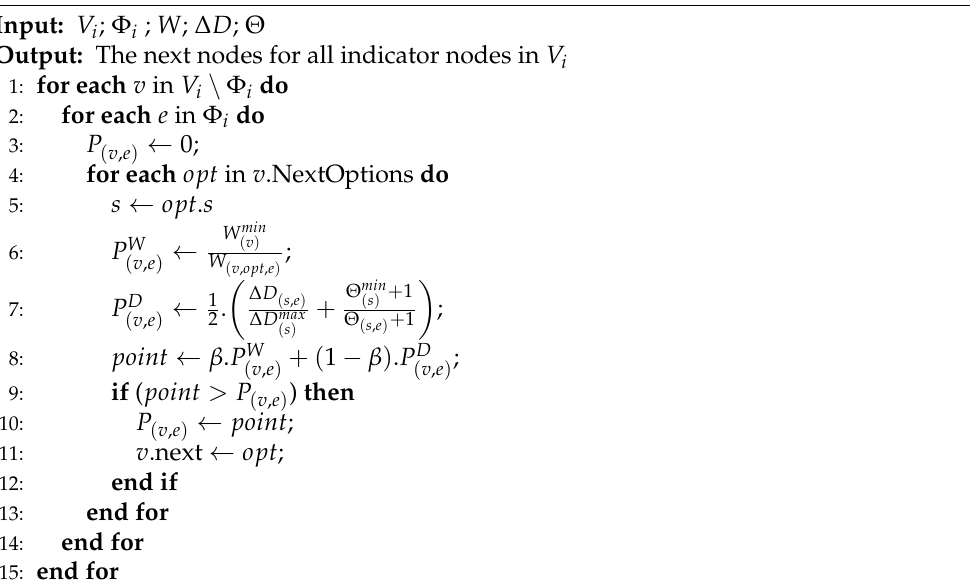
Algorithm 5 RoutesSelector —Evacuation Routes Evaluation